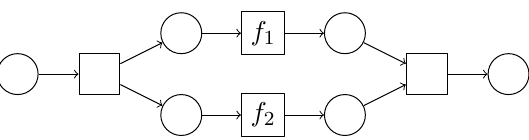
Figure 3 . Task and data parallelism in a Petri